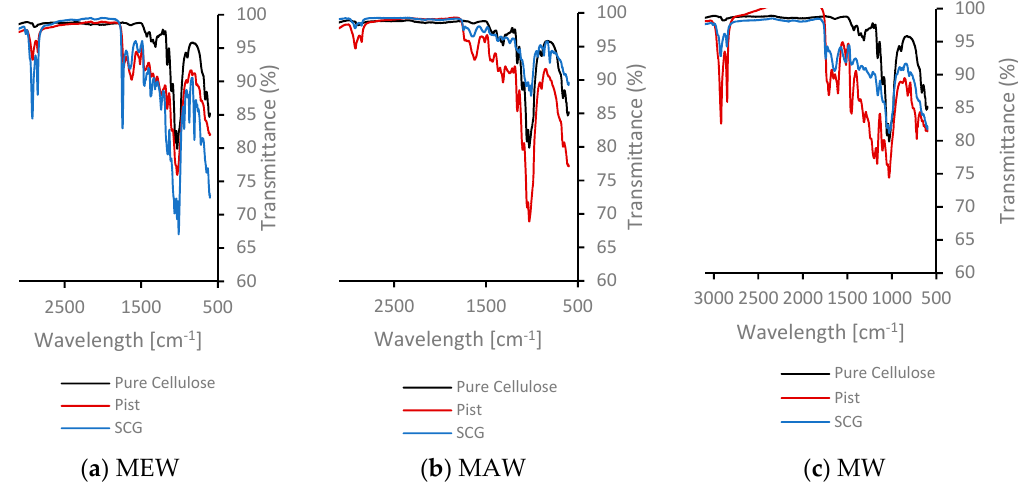
Figure 8. Fourier-transform infrared spectroscopy (FT-IR) spectra of the CEF samples.